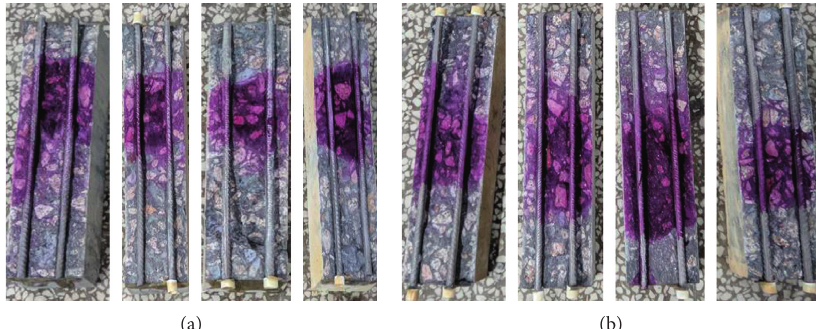
Figure 6: Flexural strength specimens after 300 days of corrosion: (a) immersion (0%, 0.27%, 0.8%, and 3%) and (b) dry-wet (0%, 0.27%, 0.8%, and